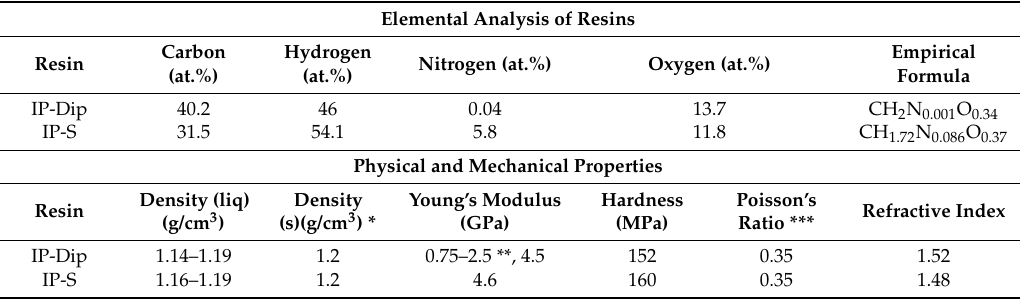
Table 1. Composition and key properties of IP-Dip and IP-S resins. Unless otherwise noted, the physical and the mechanical properties are from Nanoscribe